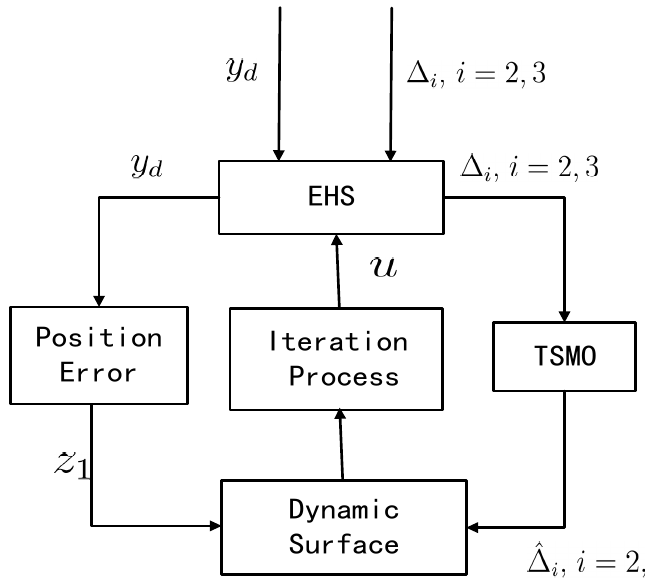
Figure 2. The control diagram of